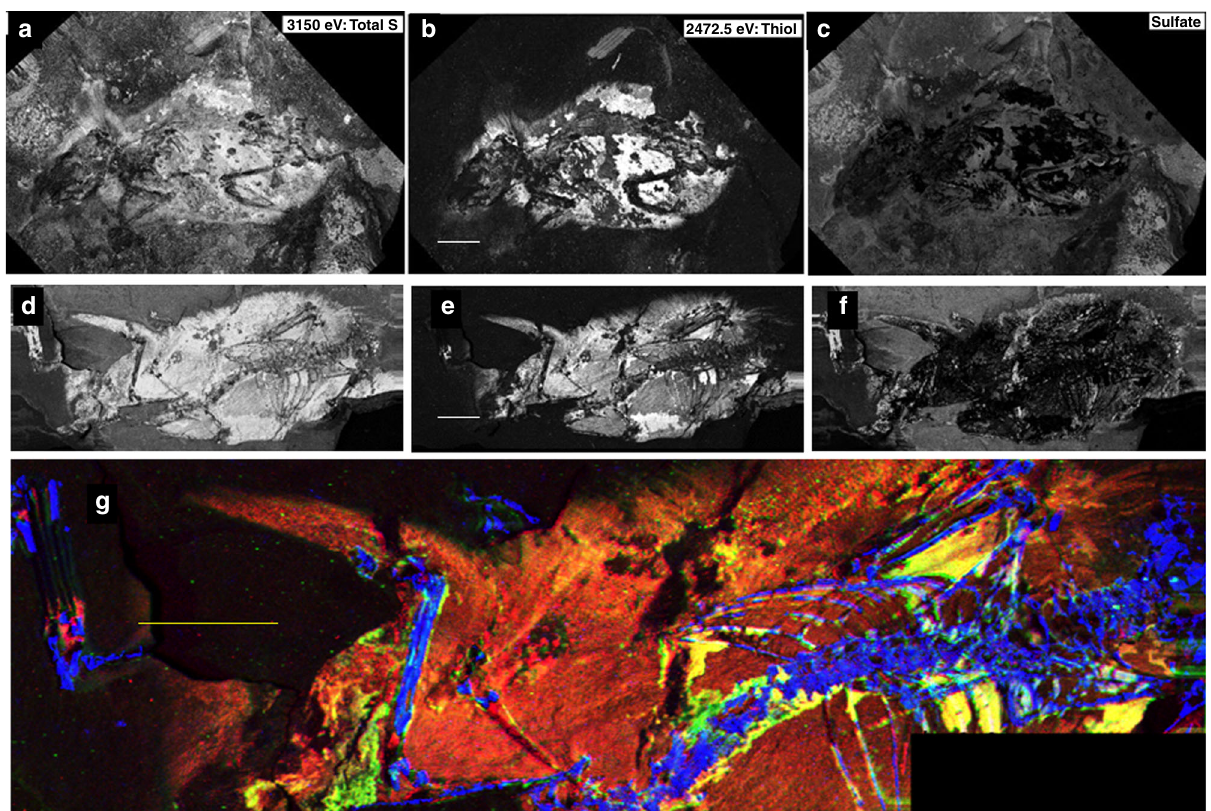
Fig. 2 X-ray image comparison of “ lateral ” and “ dorsal ” fossils. SRS-XRF map comparisons for the A. atavus lateral fossil (GZG.W.20027b: a – c ) with the “ dorsal ” fossil (GZG.W.17393a: d – g ). Maps a and d are total sulfur (incident beam energy 3150 eV). b and e show reduced organic species of sulfur (incident beam energy 2472.5 eV). c and f subtract the organic image from the total sulfur map, thus showing only inorganic sulfate. g is a false-color map (blue = P, green = Zn, and red = organic S) for the dorsal fossil comparable to that shown in Fig. 1b for the lateral fossil (scale bars = 1 cm). Bright yellow areas indicate a correlation between Zn and organic